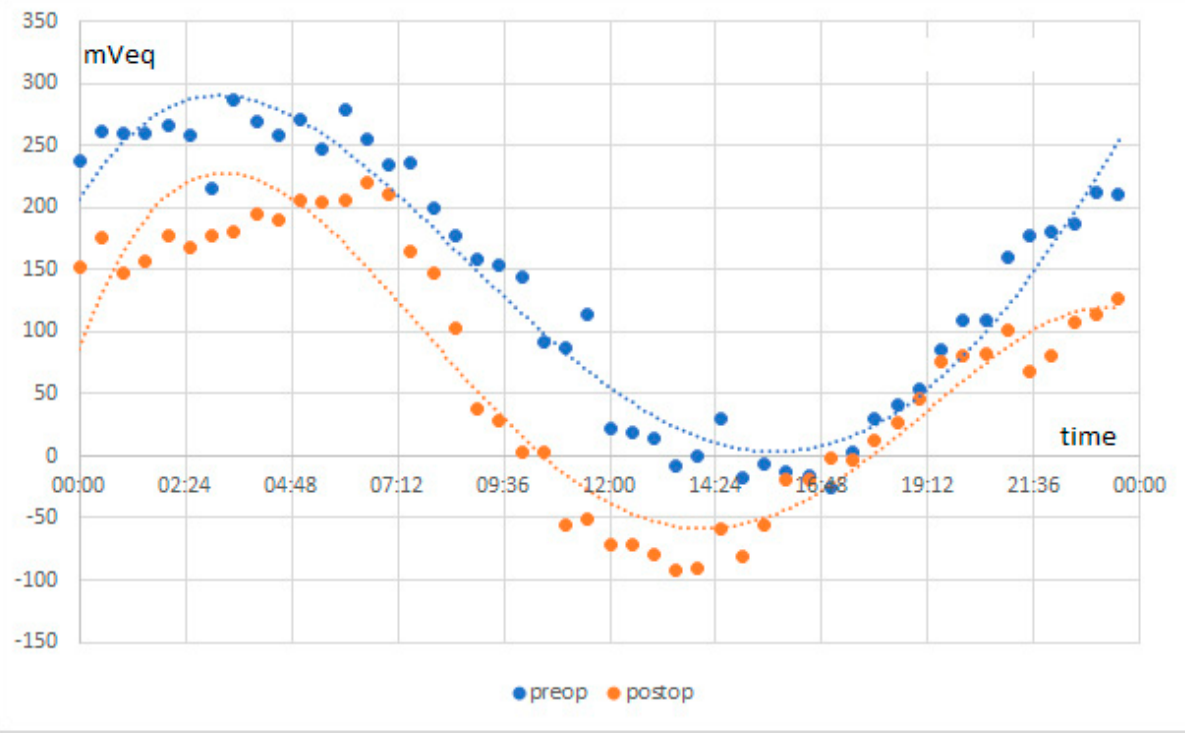
Figure 5. Triggerfish measurement results in mVeq of all patients before and after surgery.